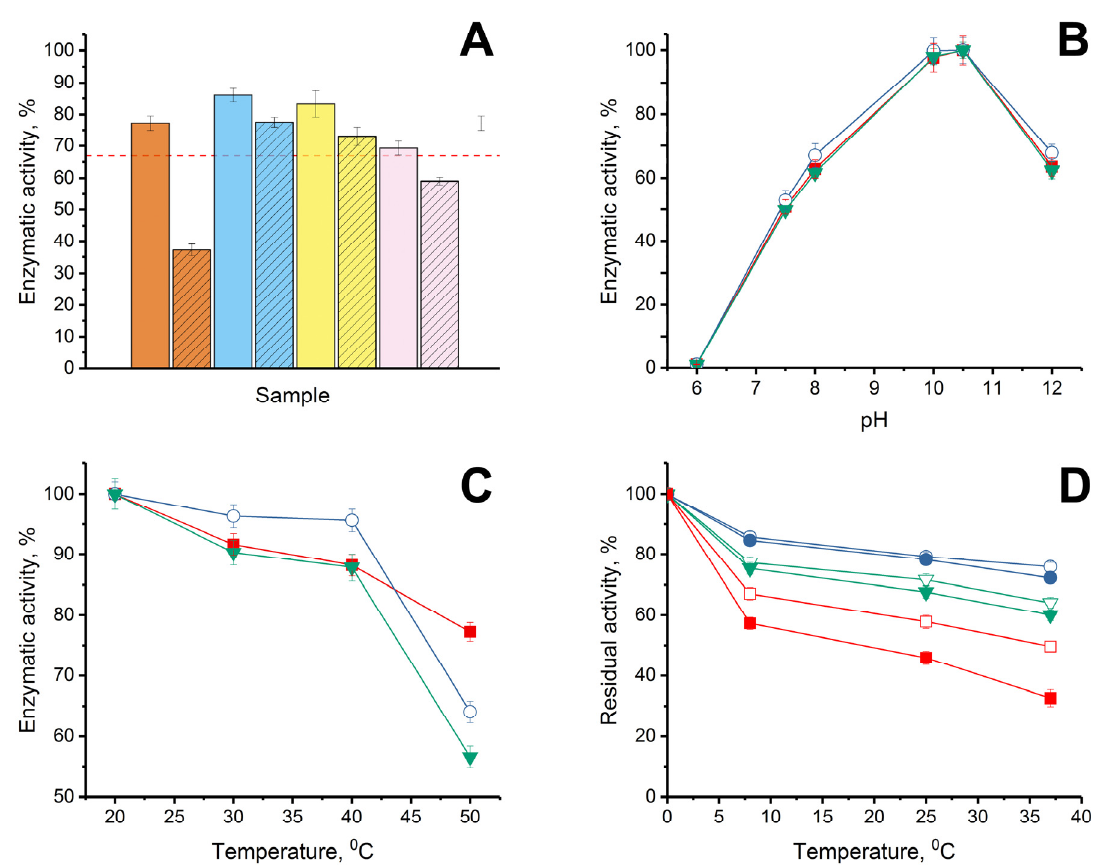
Figure 3. ( A ) Stability of enzymatic activity of His 6 -OPH without AMPs (dashed red line) and in combinations with lactoferrin (solid) and Lfcin (crosshatched), formed at pH 7.5 in the presence of 150 mM NaCl when the “enzyme:AMP” ratios were 1:0.5 (orange), 1:1 (blue), 1:2 (yellow) and 1:5 (pink) during exposure of the combinations for 72 h at 8 °C in 50 mM K-phosphate buffer (pH 7.5). Initial level of enzyme activity was assessed as 100%. ( B ) pH dependence of His 6 -OPH activity es- timated in the absence ( ) and presence ( , ) of lactoferrin and Lfcin, respectively. ( C ) Thermal inactivation of enzymatic activity of His 6 -OPH ( ), His 6 -OPH/lactoferrin ( ), and His 6 -OPH/ Lfcin ( ) combinations, formed at pH 7.5 in the presence of 150 mM NaCl during exposure for 15 min at various temperatures. ( D ) Thermal stability of enzymatic activity of His 6 -OPH ( , ), His 6 -OPH/lactoferrin ( , ), and His 6 -OPH/ Lfcin ( , ) combinations, formed at pH 7.5 in the presence of 150 mM NaCl during exposure for 72 h at 8, 25 and 37 °C at a final protein concentra- tion of 0.1 g/L ( , , ) and 0.002 g/L ( , , ). The values are presented as the average values of